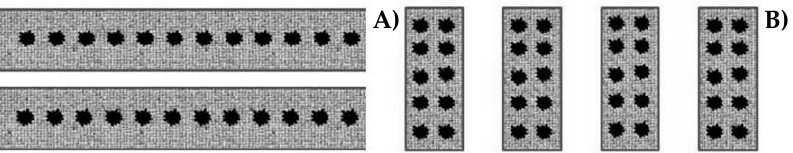
Figure 5. Mats positioned on the bottom at Capo Carbonara ( A ) and at Elba Island ( B ) and manual inclusion of cut- tings in the mat ( C , D ).